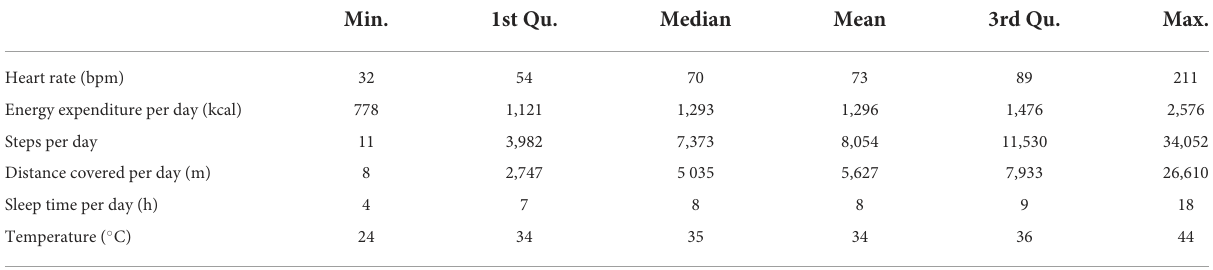
TABLE 6 Summary of wearable measurements, including heart rate, energy expenditure, steps, and distance (in meter) covered per day measured with the fitness tracker and body shell temperature (in ◦ C) measured with the thermometer patch. Min. 1st Qu. Median Mean 3rd Qu. Max.